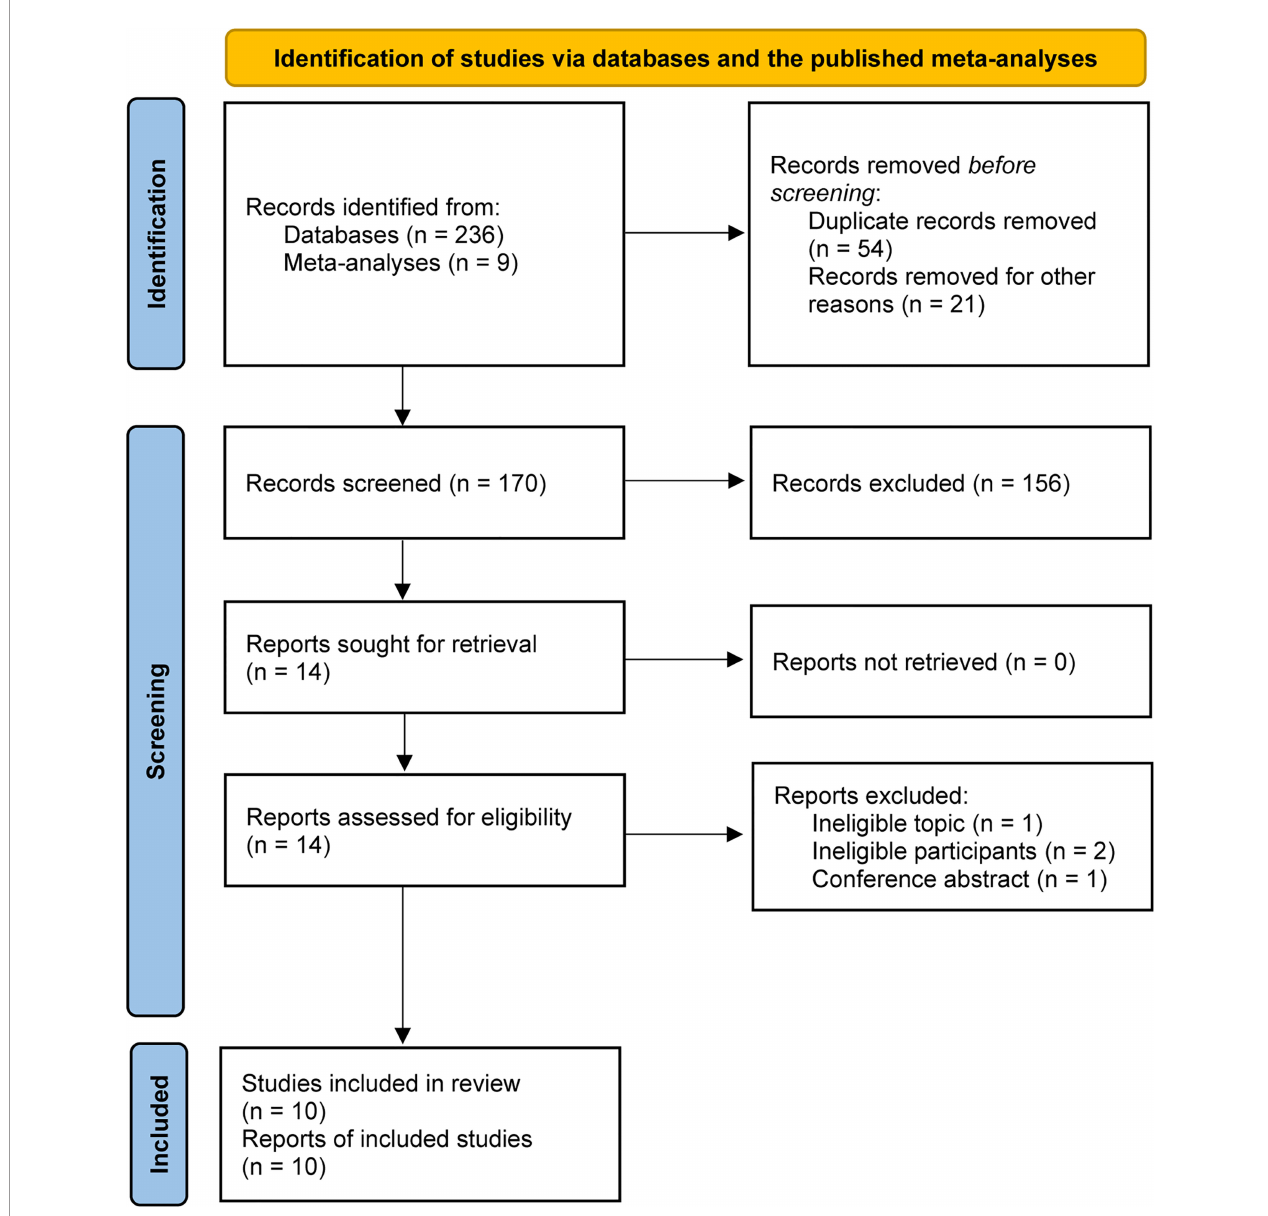
FIGURE 1 | PRISMA fl owchart of study retrieval and